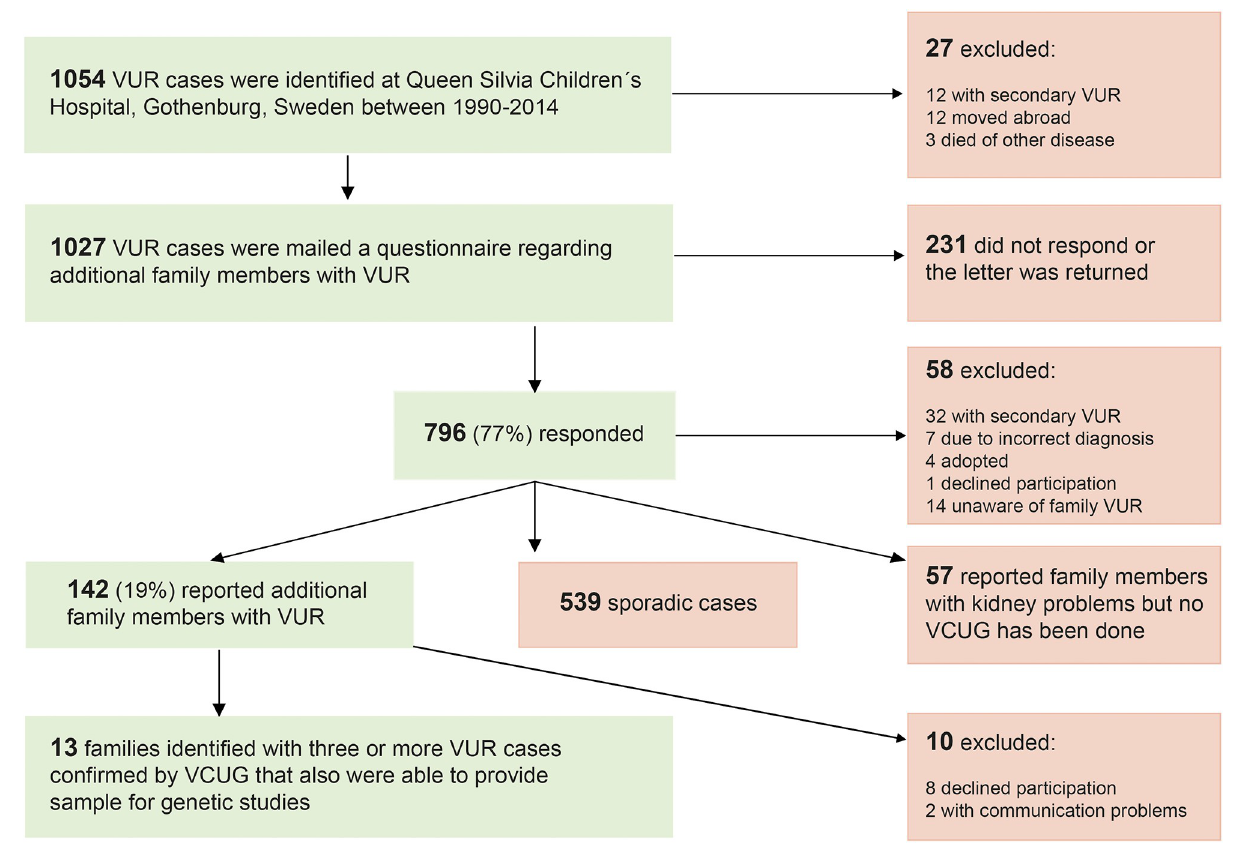
Fig 1. Data selection process for the study. CLC Biomedical Genomics Workbench software (Qiagen, Aarhus, Denmark) (S1 File) with